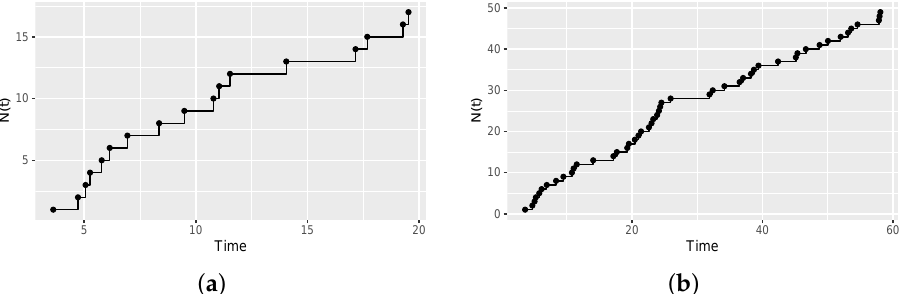
Figure 7. Simulation of a Cox process with Folded Normal intensity function of parameters µ = 7, σ 2 = 0.8 and with covariance function k Z ( h ) = 0.8 · I { 0 } ( h ) for T = 20 ( a ) and T = 60 ( b